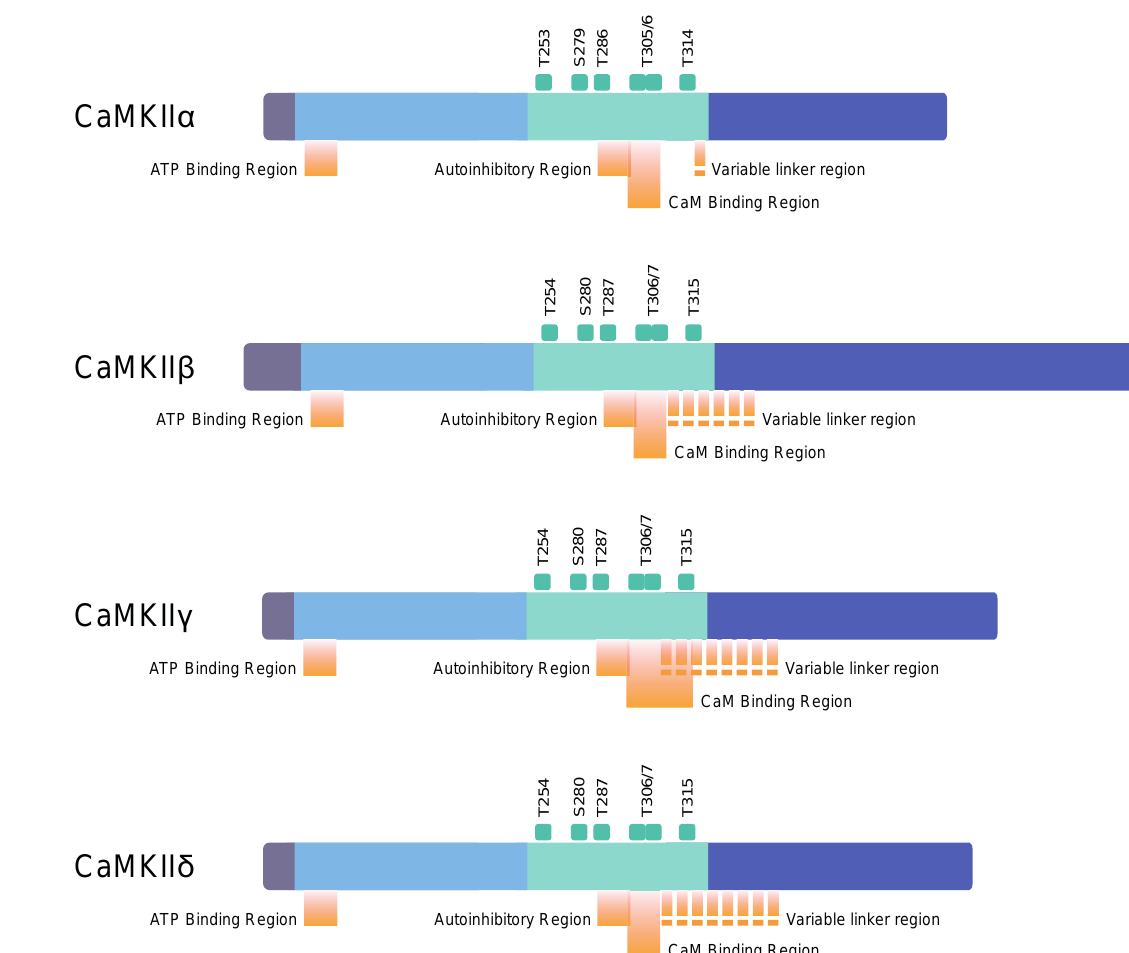
Figure 2. A domain structure of calcium/calmodulin-dependent kinase (CaMK) II (adapted from ref. [1]). We distinguish four CaMKII isoforms: α, β, γ, and δ. CaMKII structure consists of the N-terminal domain (dark gray), catalytic domain (blue), regulatory domain (green), and C-terminal association domain (dark blue). Green squares indicate phosphorylation sites.